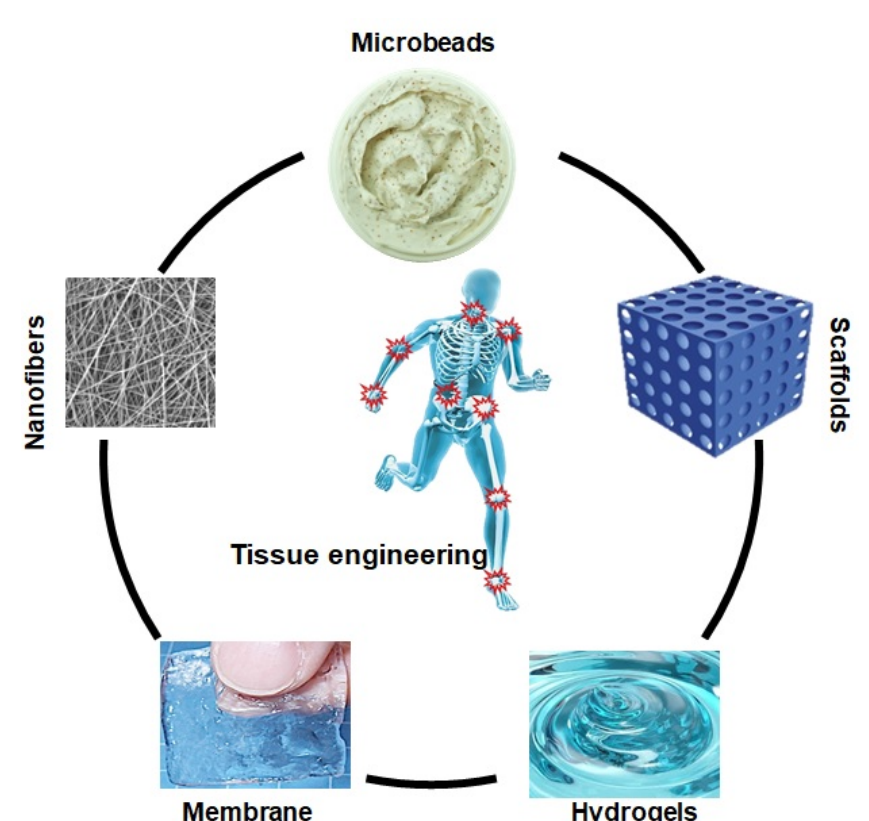
Figure 3. Biopolymer based different form of biomaterials in tissue engineering.